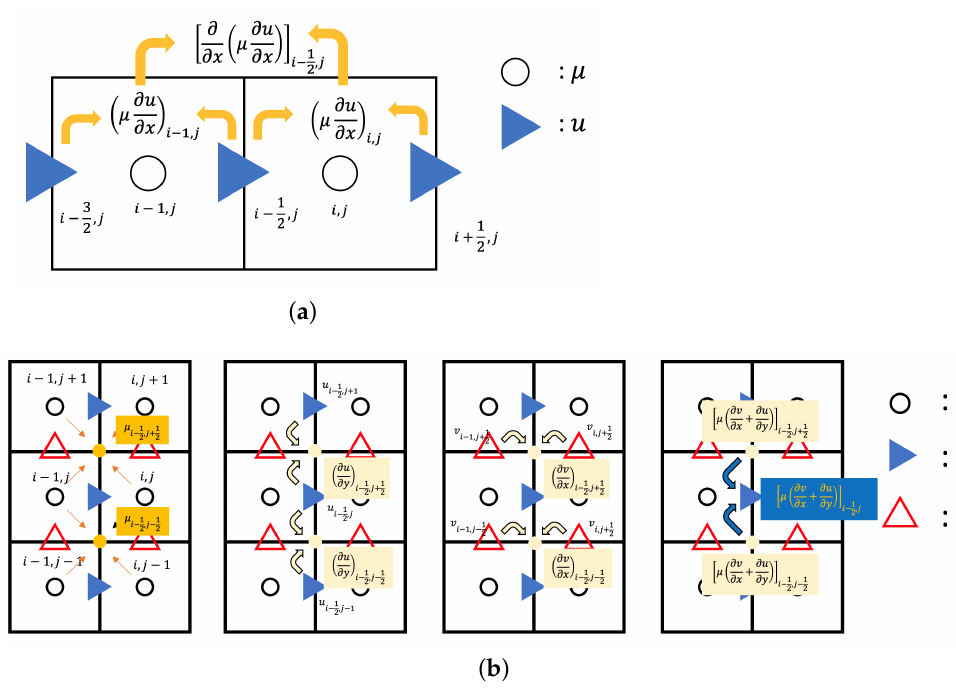
Figure 4. Stencil computations of the viscous term where ( a ) the directions of the derivative and velocity are the same and ( b ) the directions of the derivative and the velocity are different. ( a ) Sten- cil computation where the directions of the derivative and the velocity are the same. ( b ) Stencil computation where the directions of the derivative and the velocity are